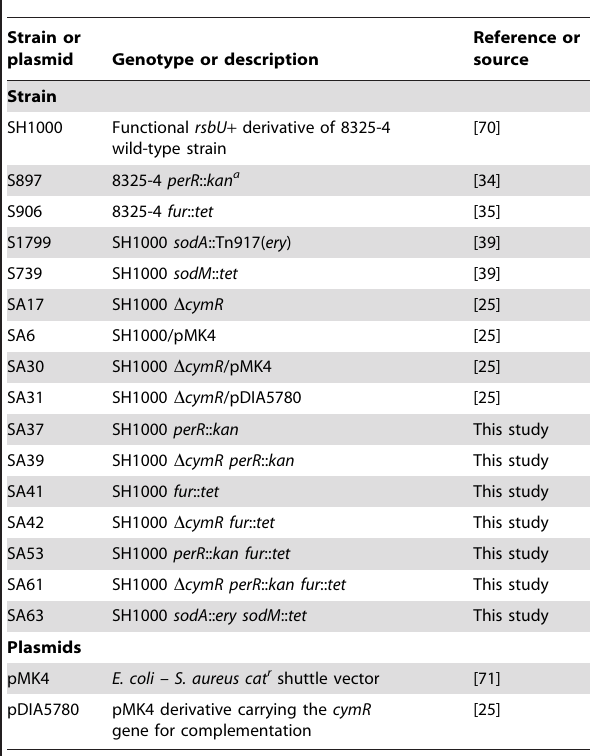
Table 2. Strains and plasmids used in this